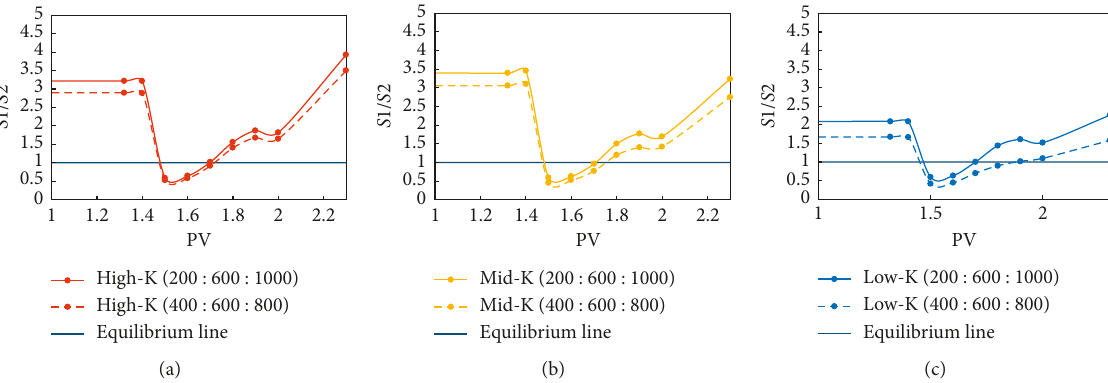
Figure 23: S of (a) high permeability layer, (b) middle permeability layer, and (c) low-permeability layer with different